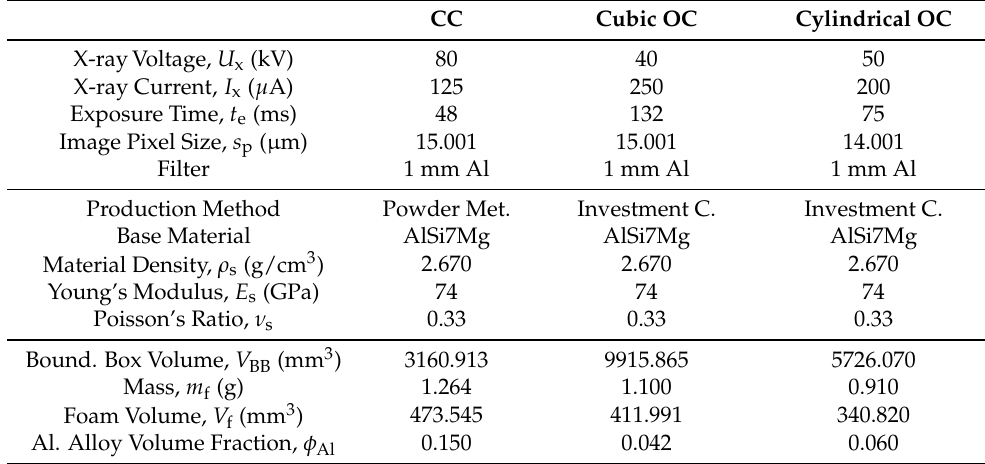
Table 1. Scan parameters, properties of the base material and final properties for the closed-cell (CC), cubic open-cell (Cubic OC) and cylindrical open-cell (Cylindrical OC) foam specimens. CC Cubic OC Cylindrical OC X-rayVoltage, U x (kV) 80 40 50 X-ray Current, I x ( µ A) 125 250 200 Exposure Time, t e (ms) 48 132 75 Image Pixel Size, s p ( µ m) 15.001 15.001 14.001 Filter 1 mm Al 1 mm Al 1 mm Al Production Method Powder Met. Investment C. Investment C. Base Material AlSi7Mg AlSi7Mg AlSi7Mg Material Density, ρ s (g/cm 3 ) 74 Poisson’s Ratio, ν s 0.33 0.33 0.33 Bound. Box Volume, V BB (mm 3